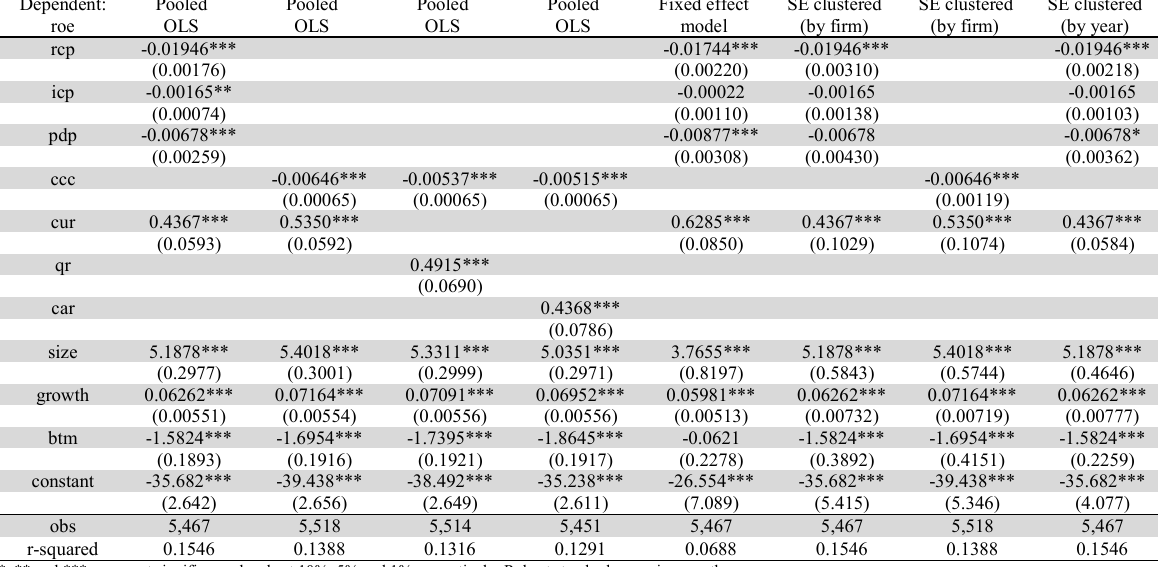
Impact of working capital management on return on equity (roe)